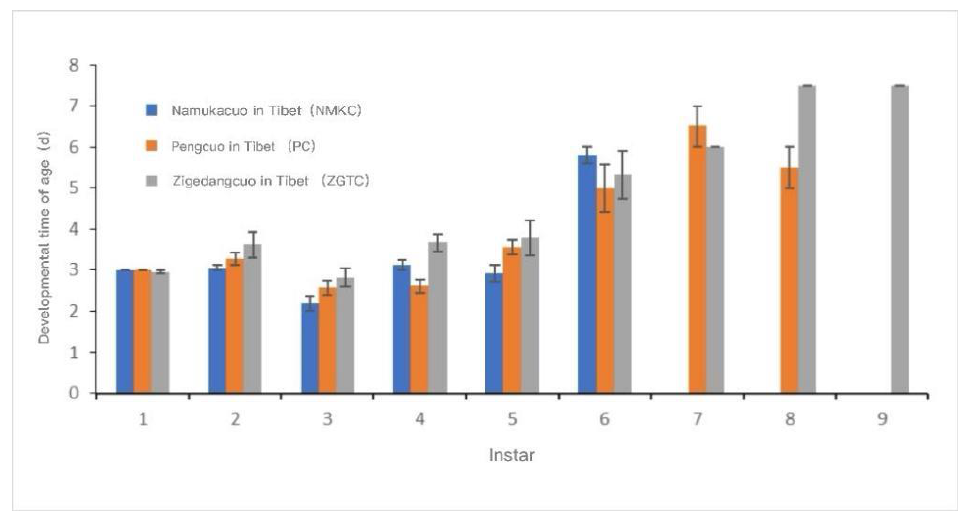
Figure 7. Instar development time of Daphniopsis tibetana from different origins.